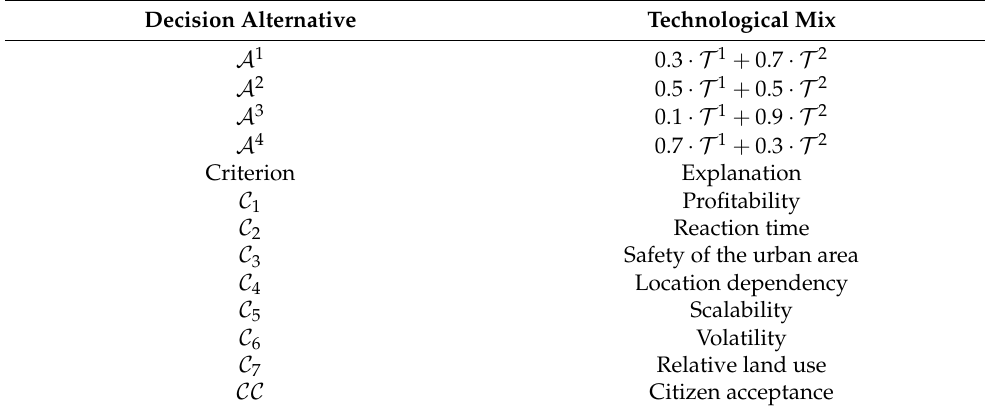
Table 2. Decision alternatives and criteria.